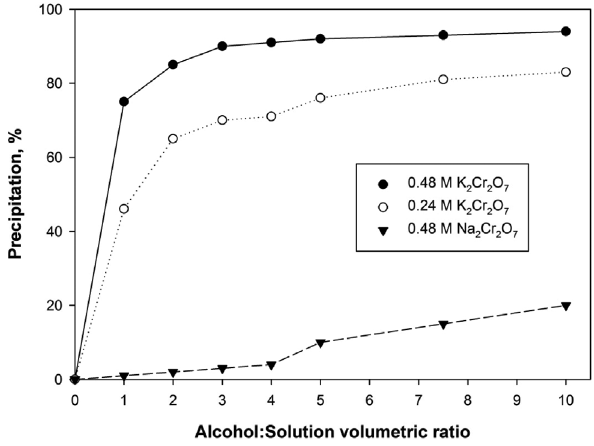
Fig. 11: Precipitation (%) of chromium as a function of the ethanol:solution volume ratio. (Room temp, 0.24 and 0.48 M sol., 300 rpm, 1 hour)